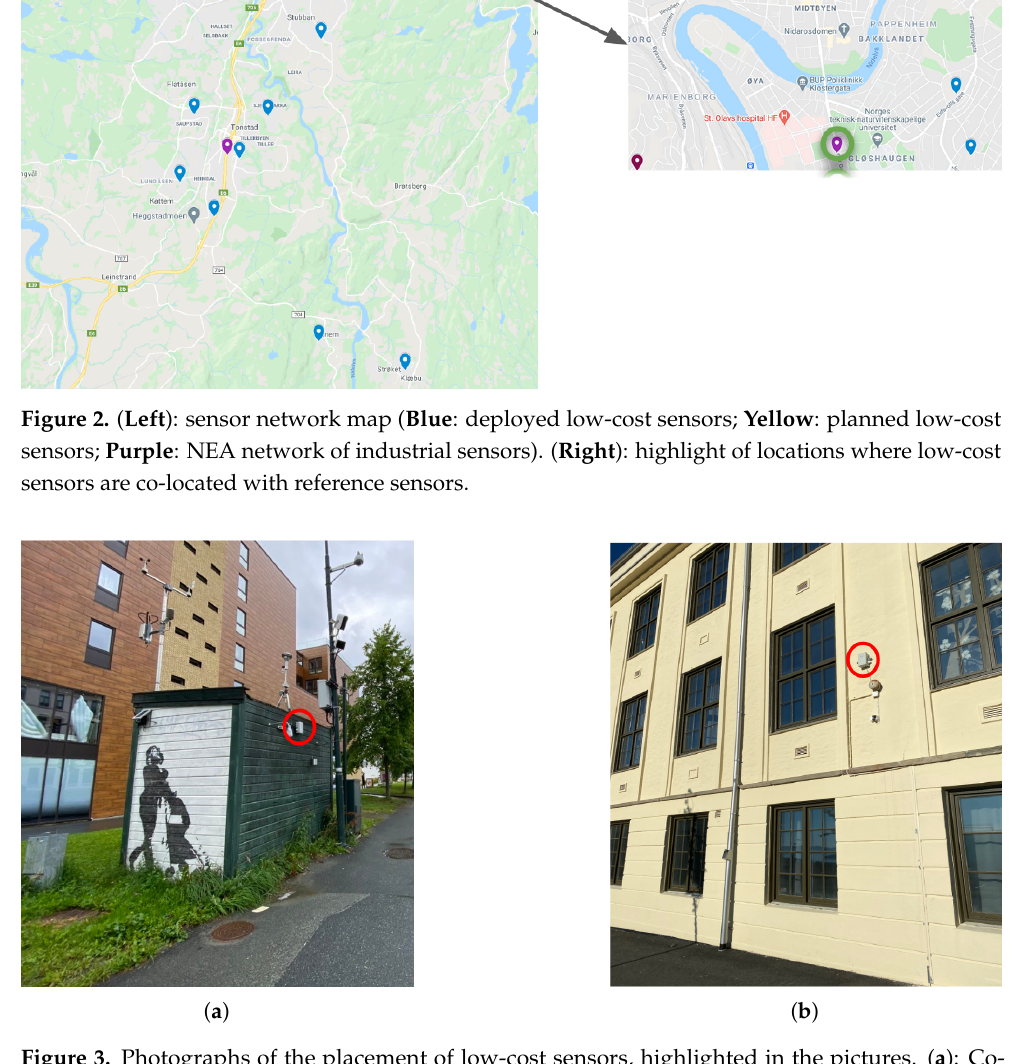
Figure 3. Photographs of the placement of low-cost sensors, highlighted in the pictures. ( a ): Co- located with a reference sensor at Elgeseter ; ( b ): at Berg